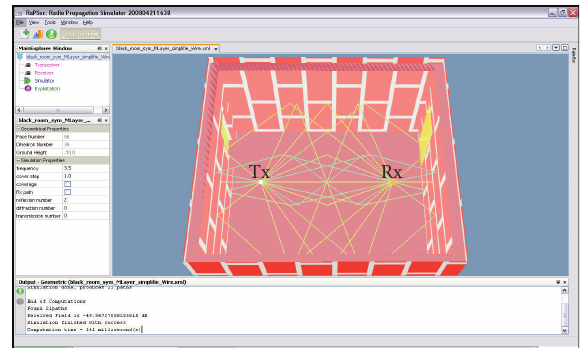
Figure 13: Geometrical paths between Tx and Rx for 2 reflexions and 0 di ff raction in the room (cf. Figure 8).